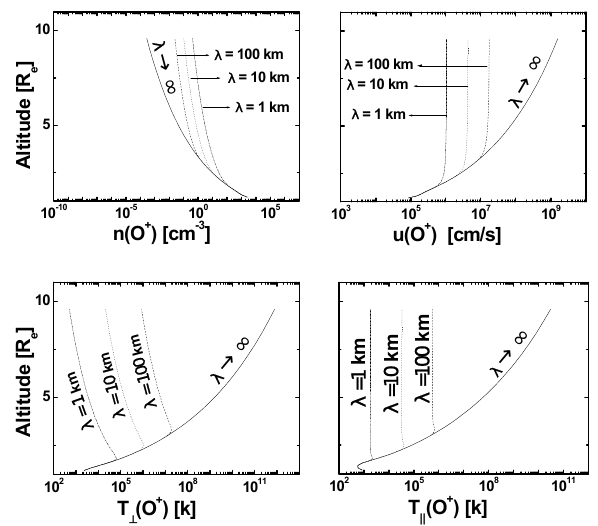
Fig. 2. Altitude profiles of the lower order O + moment for dif- ferent electromagnetic turbulence wavelengths ( λ ⊥ ) . The wave- lengths considered here are λ ⊥ →∞ (solid), λ ⊥ = 100km (dashed), λ ⊥ = 10km (dotted), and λ ⊥ = 1km (dashed dotted). The O + mo- ments considered here are: density n( O + ) (top left), drift velocity u( O + ) (top right), perpendicular temperature T ⊥ ( O + ) (bottom left), and parallel temperature T k ( O + ) (bottom right).